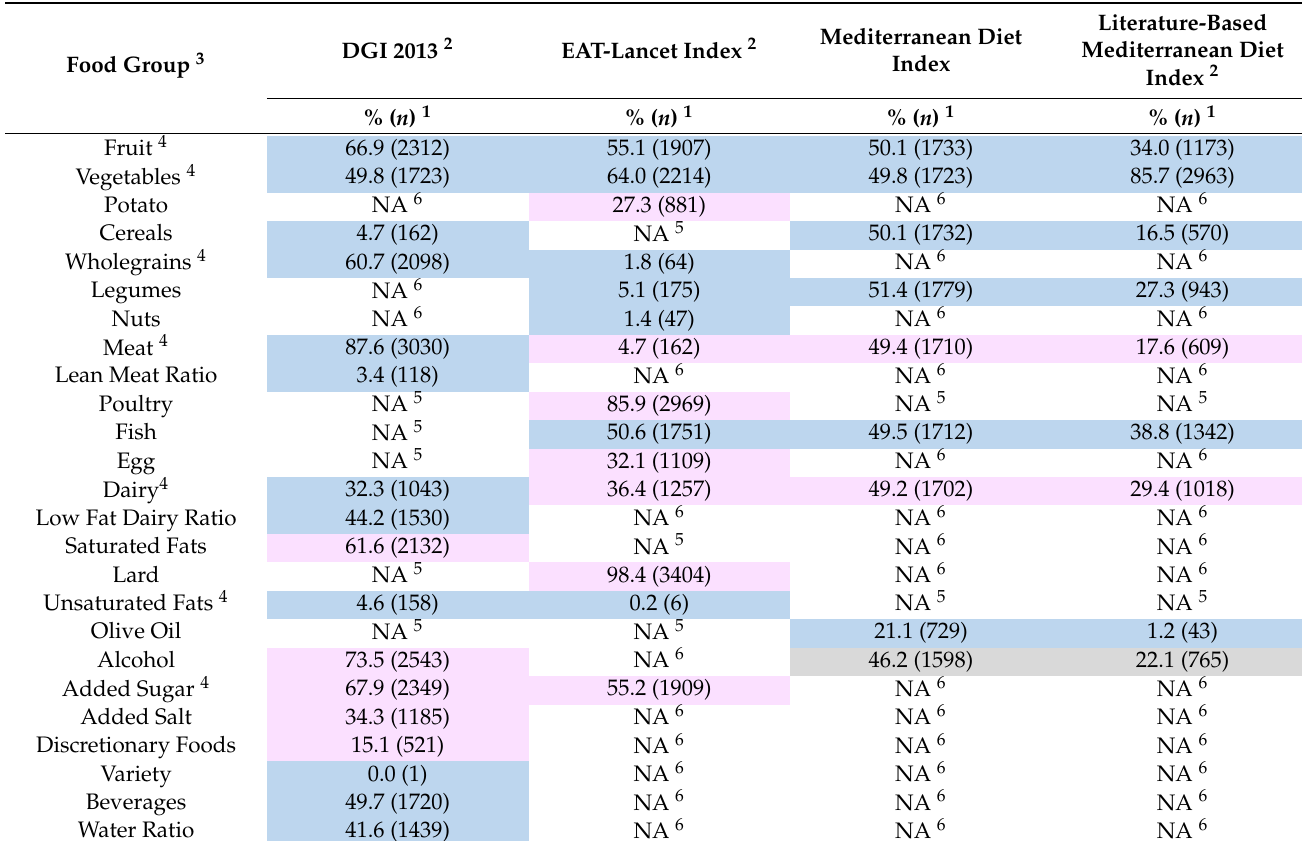
Table 2. Percentage and counts of participants achieving full points for each food group across four dietary